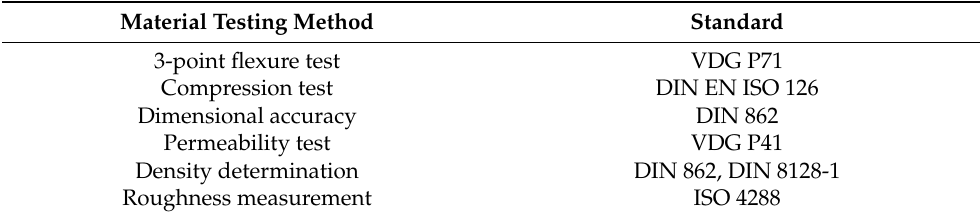
Table 1. Materials testing methods for further investigations.